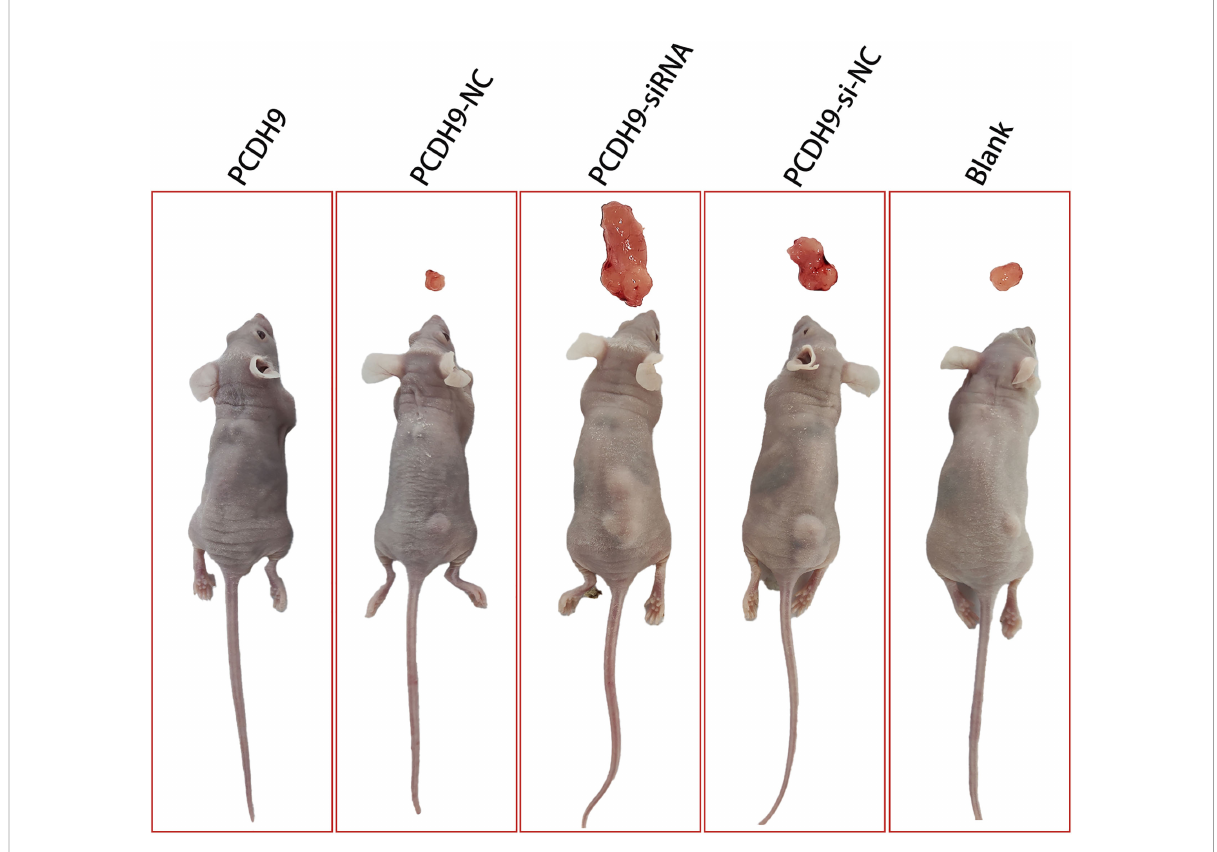
FIGURE 7 Photographs illustrated tumors in the subcutaneous xenograft tumor model. Tumors in the KD PCDH9 group were signi fi cantly heavier than those in the control and blank groups. The nude mice with overexpression of PCDH9 did not grow tumors of signi fi cant